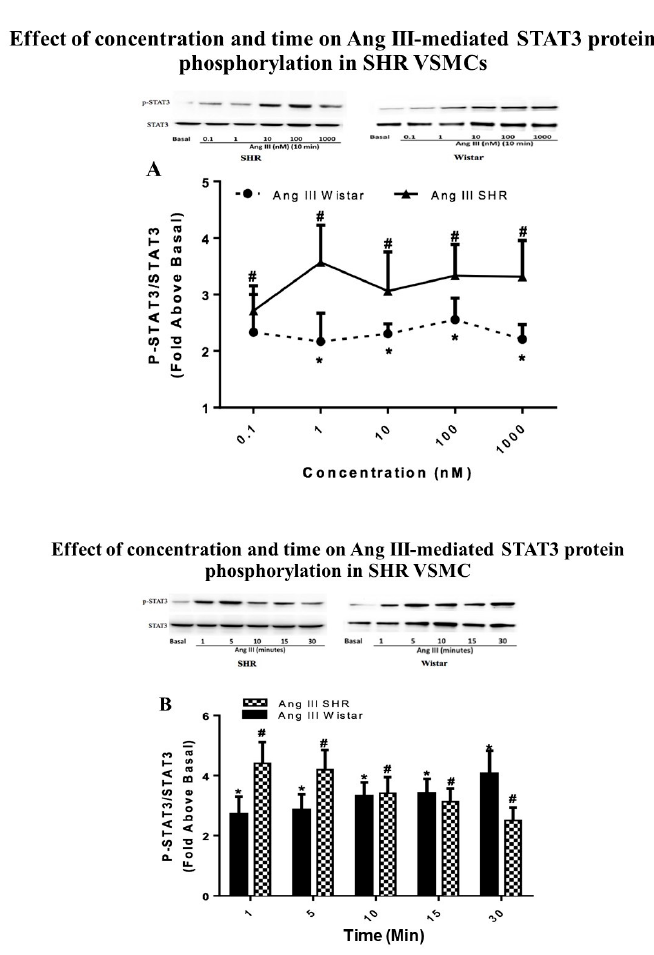
Figure 2. E ff ect of concentration and time on Ang III-mediated STAT3 protein phosphorylation in SHR VSMCs. Quiescent SHR VSMCs were treated for ( A ) 10 min with Ang III at concentrations ranging from 0.1 nM to 1000 nM or ( B ) with 100 nM Ang II or 100 nM Ang III for 1 min to 30 min. The data shown in Figure 2A,B are the same as the data in Figure 1A,B, respectively, for the Wistar Ang III data. Phosphorylated-STAT3 protein levels were measured by Western blot analysis using a specific antibody for the phosphorylated form of STAT3. Protein loading was visualized using the non-phosphorylated STAT3 antibody. The data were analyzed by densitometry and the amount of phosphorylation was calculated as the fold-increase above basal in the presence of vehicle. Each value represents the mean ± SEM of preparations of VSMCs isolated from at least five Wistar or SHRs. * Denotes p < 0.05 as compared to basal levels of STAT3 expression in VSMCs isolated from Wistar rats. # Denotes p < 0.05 as compared to STAT3 basal levels in VSMCs isolated from SHRs. 2.3. Effects of AG490 and Ang Receptor Blockers on Ang III-induced STAT3 Phosphorylation Quiescent VSMCs were preincubated with the JAK2 inhibitor (AG490, 50 µM), or with 10 µM Losartan (AT 1 R blocker) or with 10 µM PD123319 (AT 2 R blocker) for 15 min followed by 100 nM Ang III for 10 min. Co-treatment of VSMCs with AG490 and Ang III completely abolished all of Ang III’s effect on P-STAT3. Treatment with AG490 alone had no effect on basal P-STAT3 (Figure 3A).